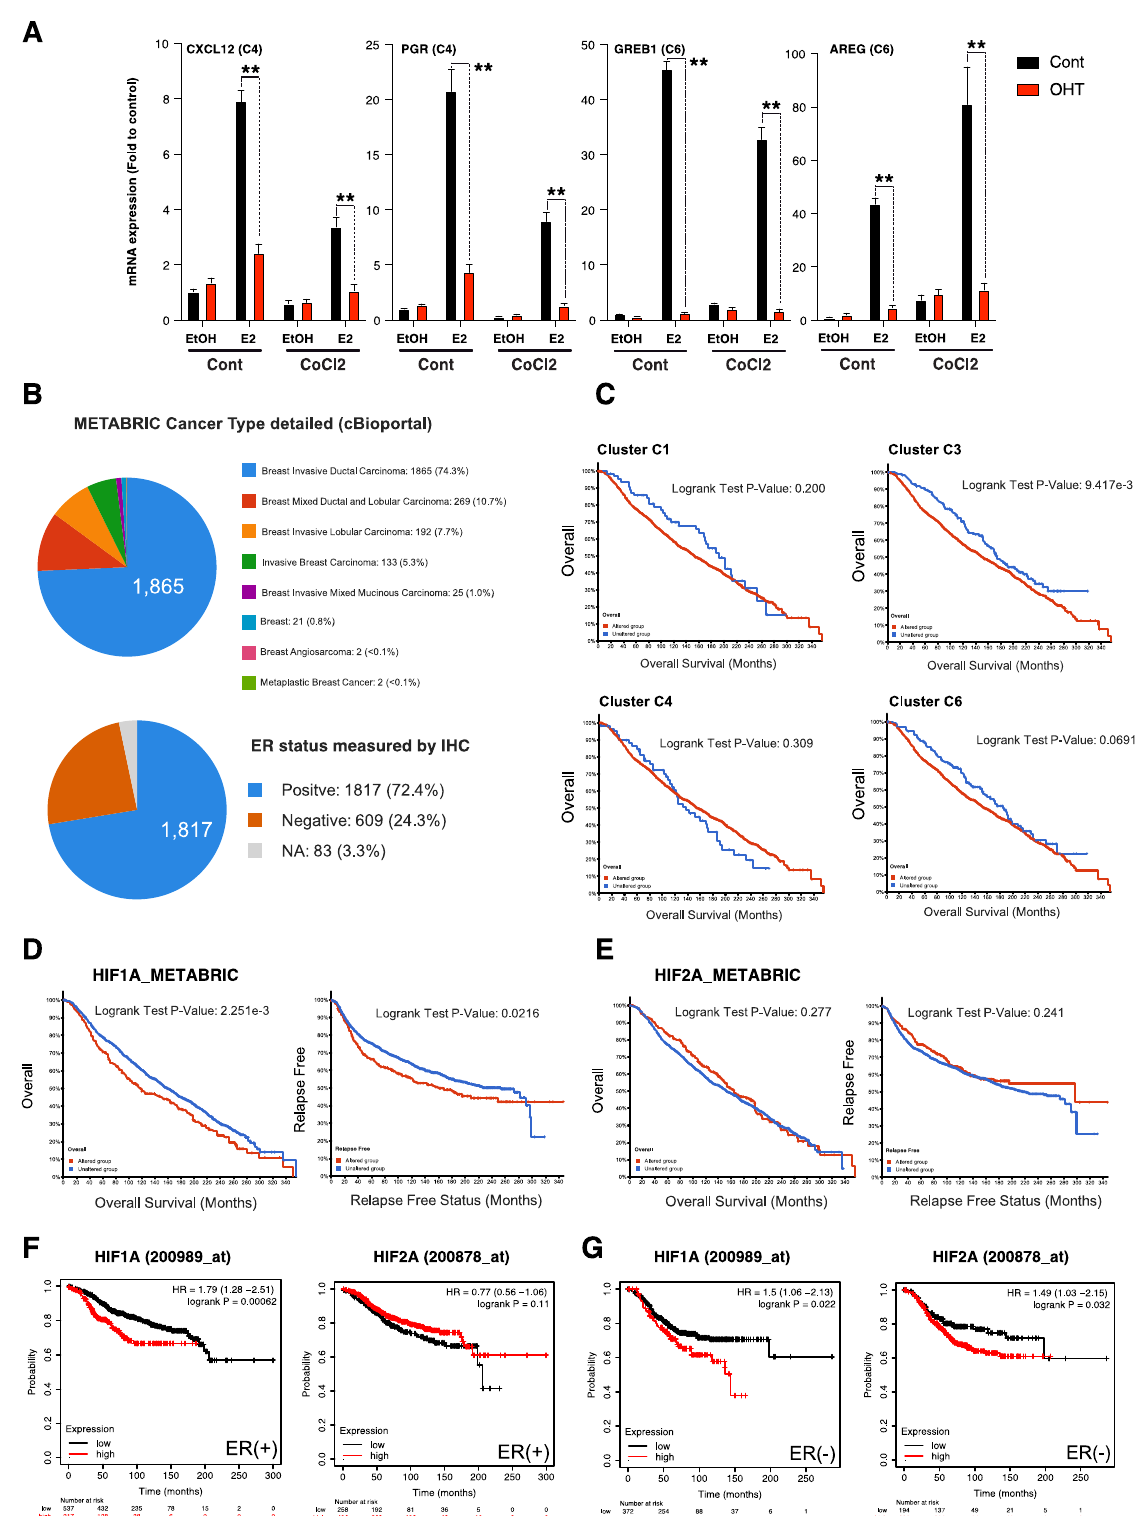
Figure 5. Hypoxia prevents a tamoxifen inhibitory effect on a subset of ER α target genes associated with poor survival prognostic of patients with luminal breast cancers. ( A ) RT-qPCR shows CXCL12, PGR, GREB1 and AREG expression level after 24 h exposure to CoCl2, in presence or absence of 10 nM of E2 and/or 1 µ M 4-hydroxytamoxifen (4-OHT) for 24 h. Values represent the mean +/ − SD